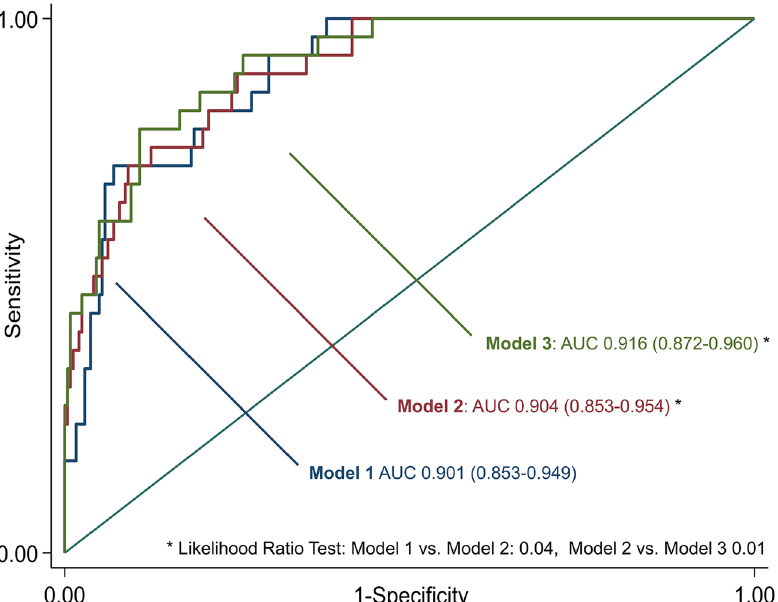
Figure 1. ROC curves comparing the goodness-of-fit of three different predictive models: Model 1: age, NIHSS, CHF, AF, CRP (log-transformed). Model 2: includes SIRT6 (log-transformed). Model 3: includes a second- order polynomial function of SIRT6. AF: atrial fibrillation; CHF: chronic heart failure; CRP: C reactive protein; NIHSS: National Institute of Health Stroke Scale; SIRT6: Sirtuin